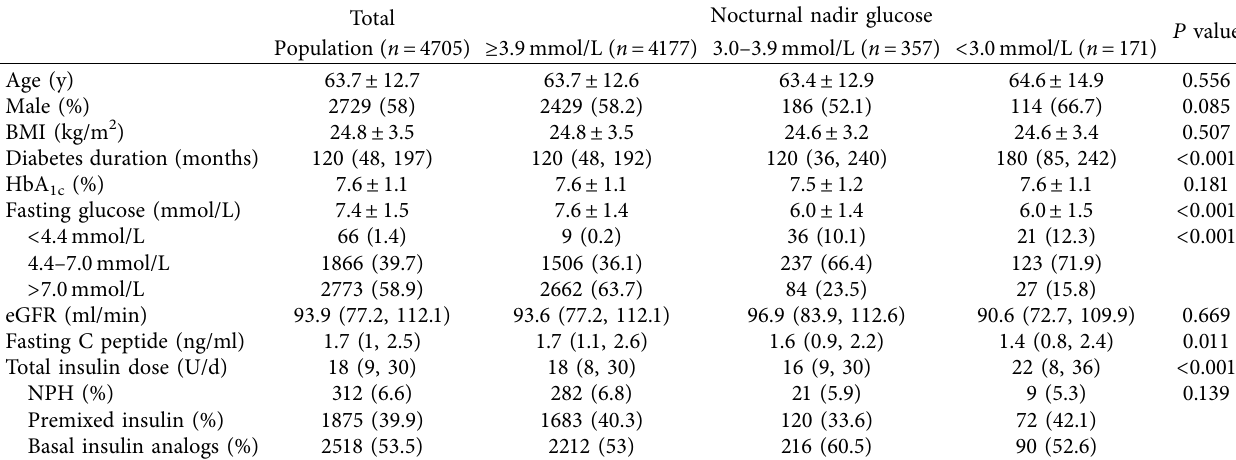
Figure 1: Patients’ disposition. Table 1: Characteristics of participants illustrated by total population and by subgroups of nocturnal nadir